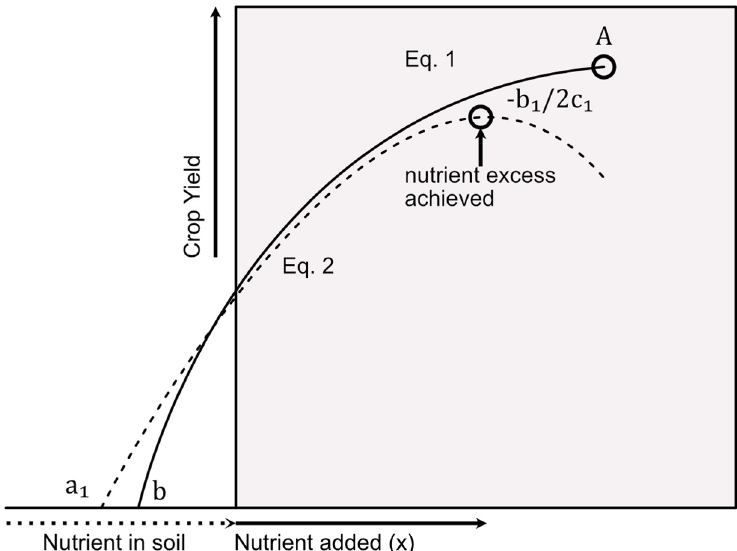
Figure 1. Crop response curves for Equation (1), nutrients present in adequate amount, and 2, nutrients present in excess (based on diagram from [14]).